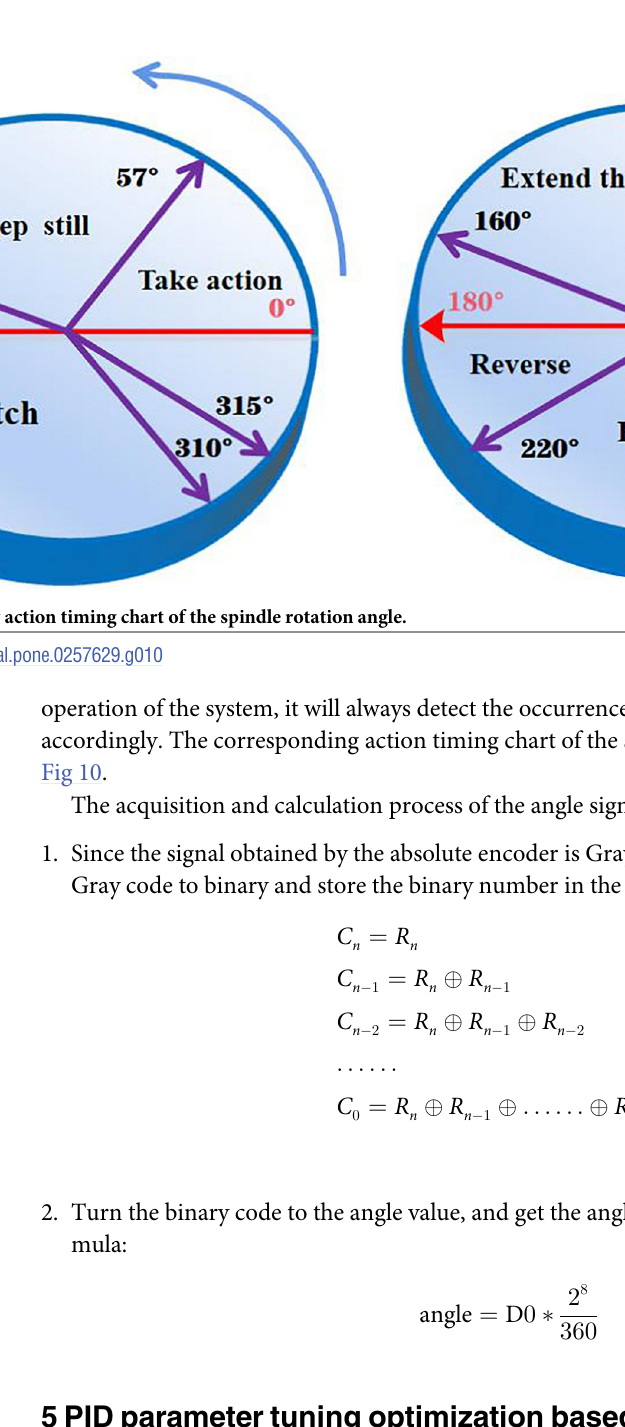
5 PID parameter tuning optimization based on genetic algorithm